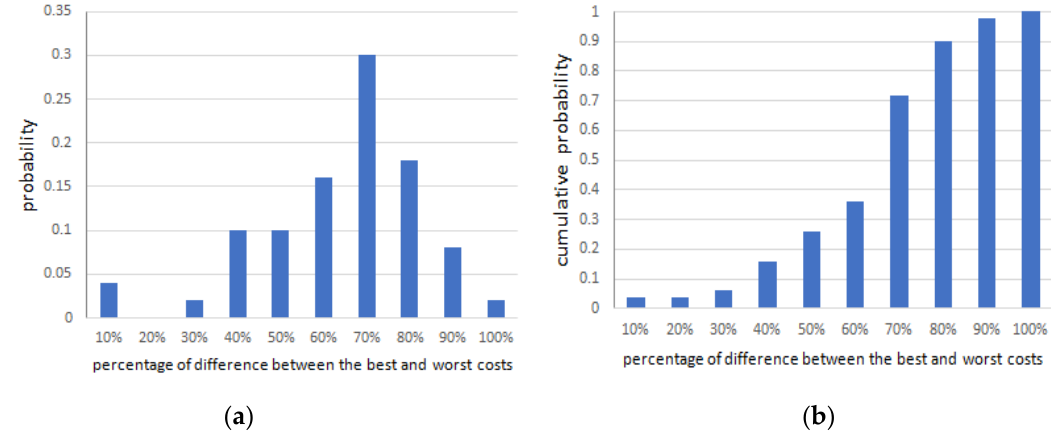
Figure 12. ( a ) Probability; and ( b ) cumulative probability with respect to the percentage of difference between the best and worst